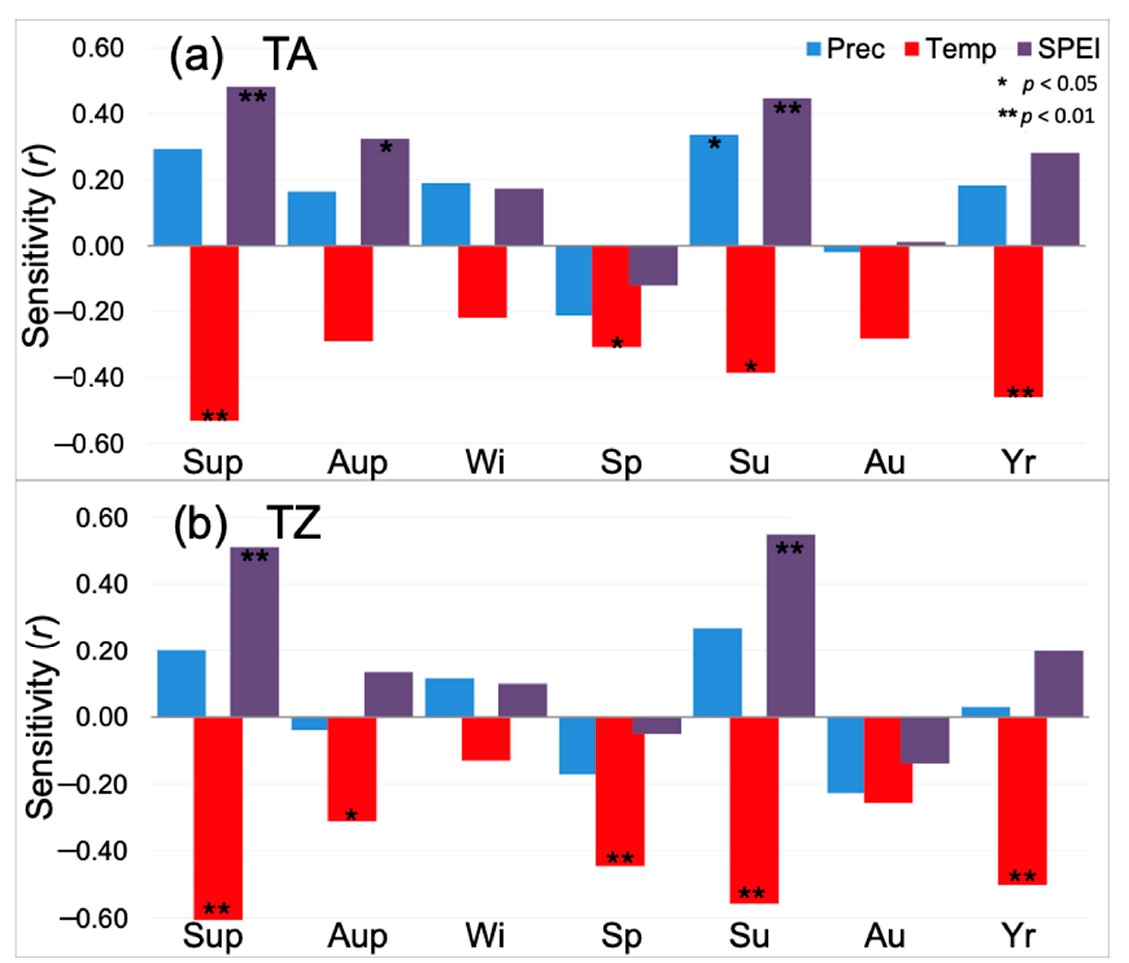
Figure 3. Climate sensitivity (correlation) of mean growth (mean basal area increment) for the period 1961–2018 of Abies marocana trees from Talassemtane, TA ( a ) and Tazaot, TZ ( b ) ranges. Sensitivity was tested at seasonal and annual scales for mean temperature (red), total precipitation (blue), and the SPEI drought index (purple). Seasonal scale was defined by mean (sum) of three-monthly scale temperature (precipitation), while seasonal-scale SPEI data were directly obtained from the database using the available three months estimates (noted as SPEI_3); similarly, annual estimates consider the hydrological year (prior September to current August), and the August estimate of SPEI_12 (Yr). Seasons are noted as winter (Wi), spring (Sp), summer (Su), and autumn (Au), including December– February, March–May, June–August, and September–November, respectively. Further, we consider seasonal correlations for summer and autumn of the previous year of tree-ring formation (Sup and Aup, respectively). * and ** indicate significant correlations after Bonferroni correction at a threshold of p < 0.01 and p < 0.05,